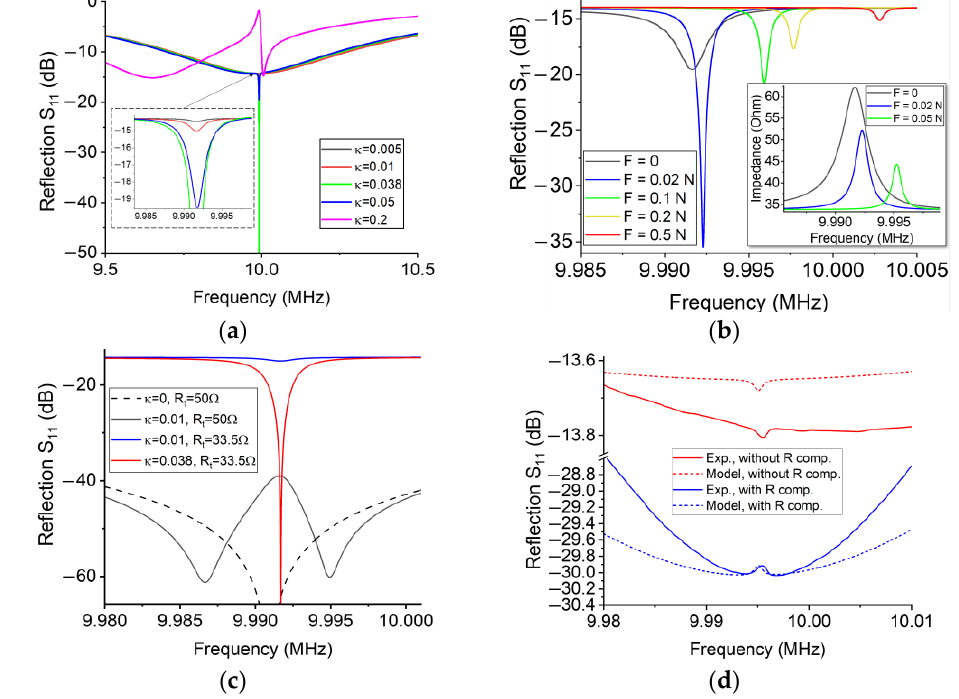
Figure 8. Characterization of the signal of BAW passive wireless sensors. ( a ) Coupling coefficient κ vs. reflection S 11 . No force is applied to the wafer. ( b ) Contact force vs. reflection S 11 . κ is 0.05. ( c ) Tunable optimal positions. The black solid curve is the optimal position for κ = 0, whereas the red solid curve is the optimal position for κ = 0.038. ( d ) Experimental verification of the compensation of the real part of the transmitter. According to the experimental measurement, we adjusted the coefficients of the model. The experiment result was the average of five repeated measurements.